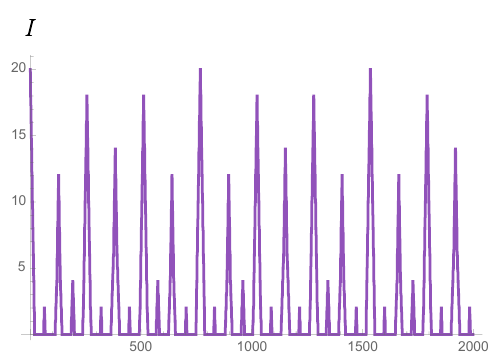
Figure 17 . The BOMI for symmetric intervals of length 10 is shown for a Cli(cid:11)ord circuit made exclusively of CNOT gates. We see recurrence at t rec (cid:24) 800 (cid:24) O ( L =